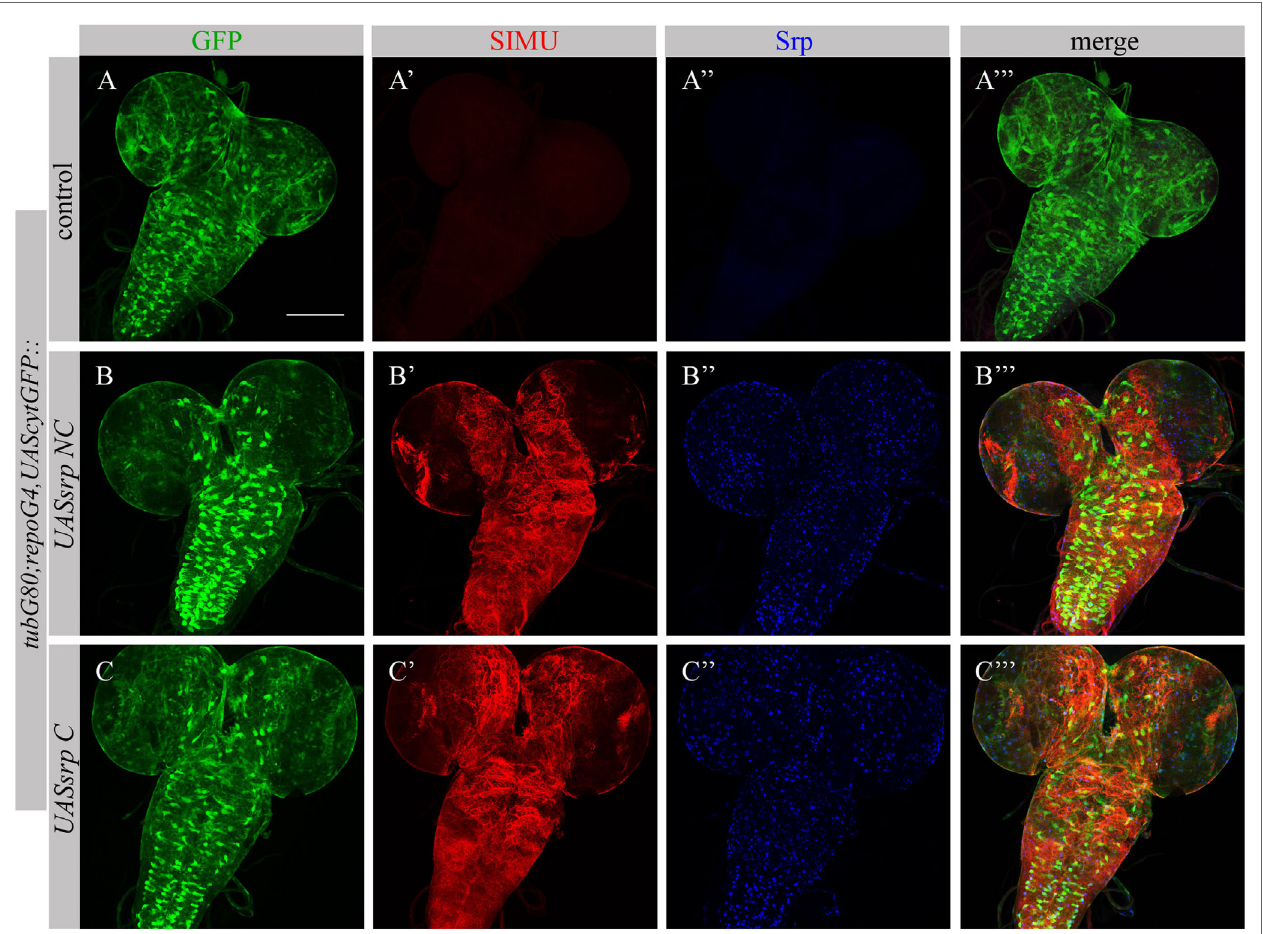
FigUre 6 | Each Srp isoform (SrpC and SrpNC) is sufficient to drive SIMU expression. (a–c’’’) Projections from confocal stacks of the 3 rd instar larval brains stained with anti-SIMU [red, (a’,a’’’,B’,B’’’,c’,c’’’) ], glia are labeled with repoGal4,UAScytGFP [green, (a,a’’’,B,B’’’,c,c’’’) ], anti-Srp [blue, (a’’,a’’’,B’’,B’’’,c’’,c’’’) ]. Bar, 100